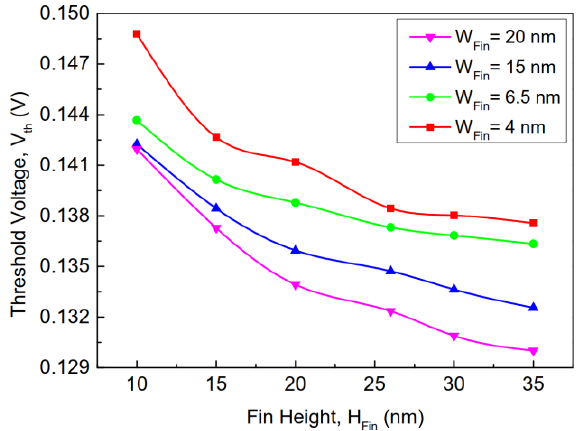
Figure 7. Behavior of the threshold voltage as a function of fin height for FinFET devices with different values of the fin width at V ds = 0.05 V.